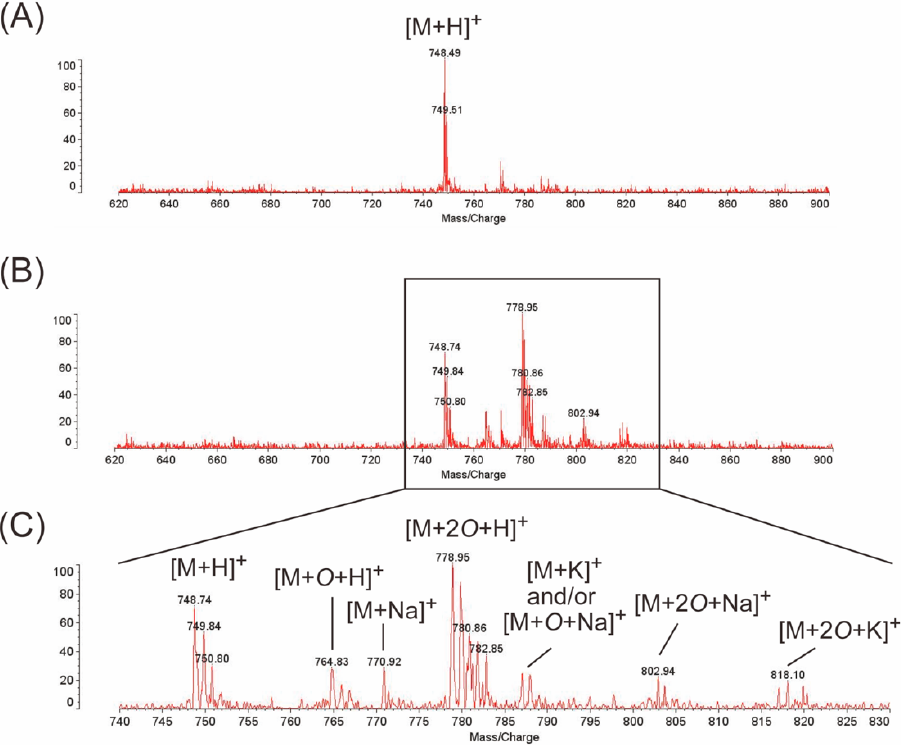
Figure 7. MALDI-TOFMS data obtained from ( A ) RU065 4–8 ( j ) only, ( B ) mixture of HAuCl 4 , H 2 PtCl 6 , and RU065 4–8 ( j ), and ( C ) expanded region of mass spectrum in panel B. The symbols ‘ O ’ in the labels indicates an oxygen atom added to the anthracene ring of RU065 4–8 ( j ). Peptide = 2.0 × 10 − 4 M, HAuCl 4 = H 2 PtCl 6 = 5.0 × 10 − 5 M in water. Each reaction was conducted at 40 ° C for 24 h in the dark.